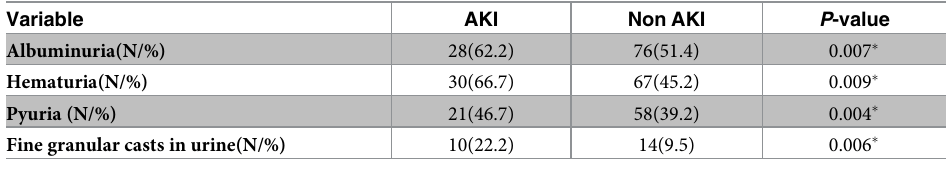
Table 4. Risk factors for the development of AKI among patients with COVID-19.